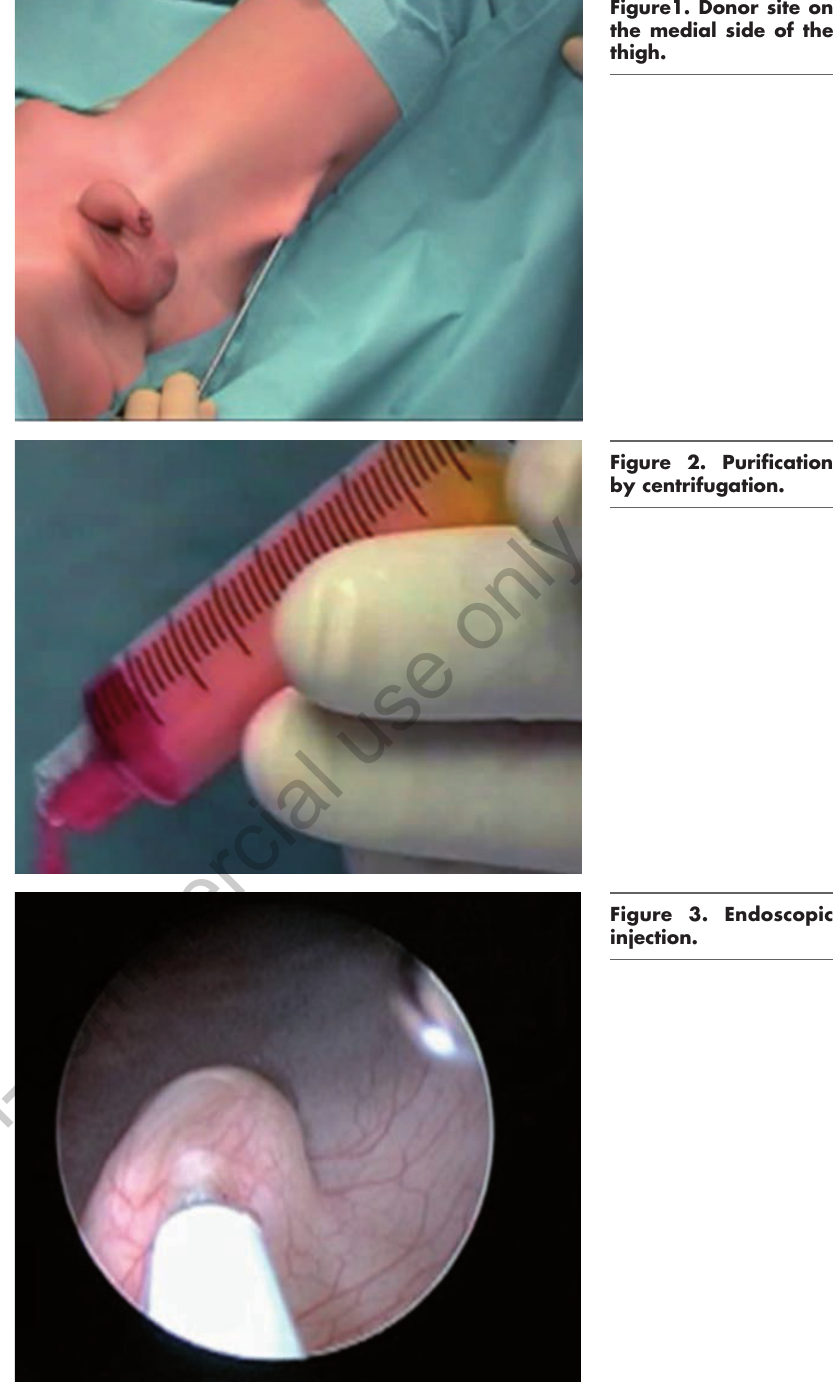
Figure 3. Endoscopic